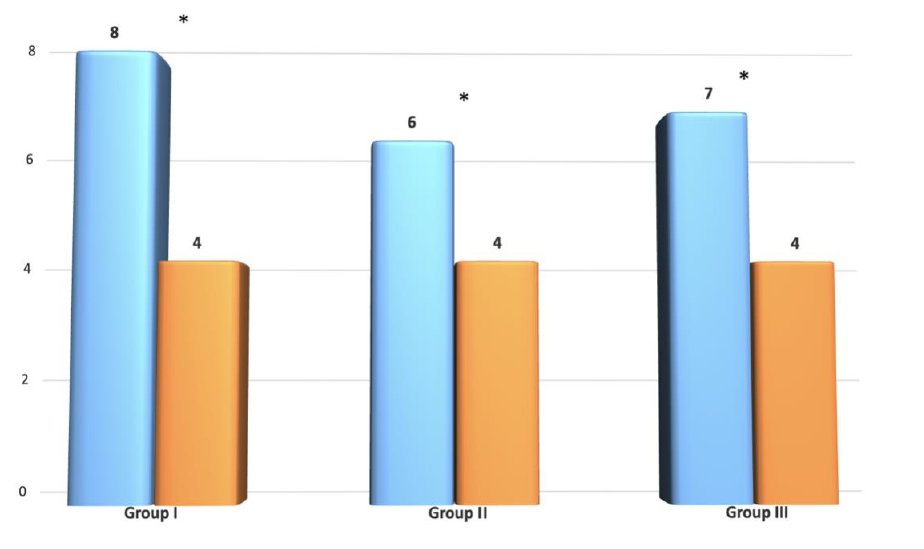
Figure 4. Comparison of the level of pain on the Laitinen scale before and after therapy in each group and between groups after therapy (results in points). Table 1. The differences (magnitude of improvement) between groups before and after treatment. Parameter Test K-W ( p ) Group I Group II Group III Difference on the VAS p = 0.003 35.5 18.5 26.5 Difference on the Laitinen p = questionnaire